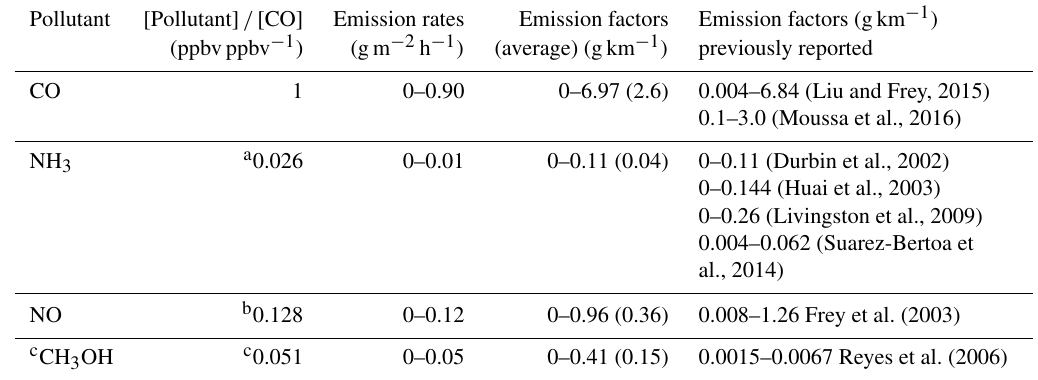
Figure 12. Average diurnal cycles of CH 3 OH mixing ratio on weekdays (a) and weekends (b) for the 16-day study period. Solid green lines are medians, and the shaded areas are the interquartile ranges. Table 2. Pollutant emission